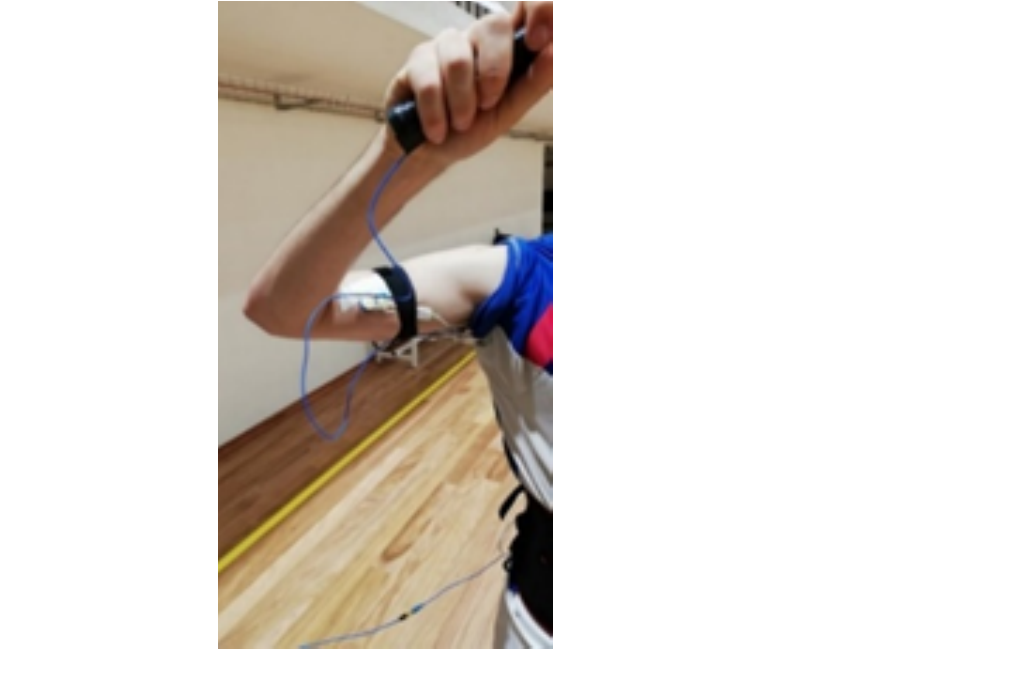
Figure 4. Electromyographic instrumentation of the